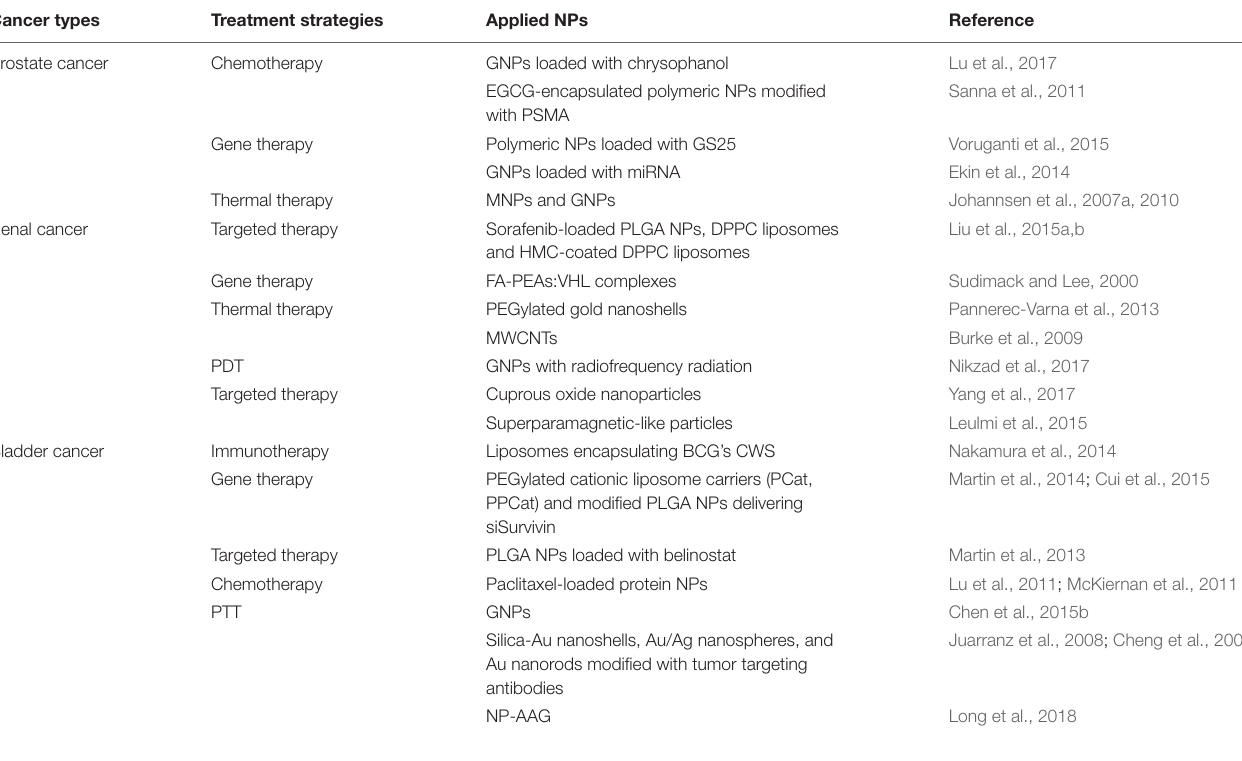
TABLE 1 | Overview of NPs designed for urological cancer